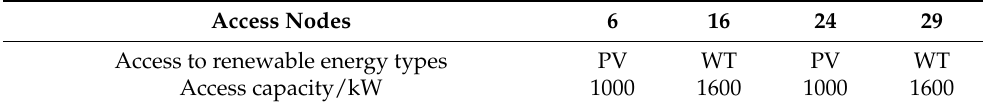
Figure 6. IEEE 33-node distribution network. Table 1. Renewable energy configurations.